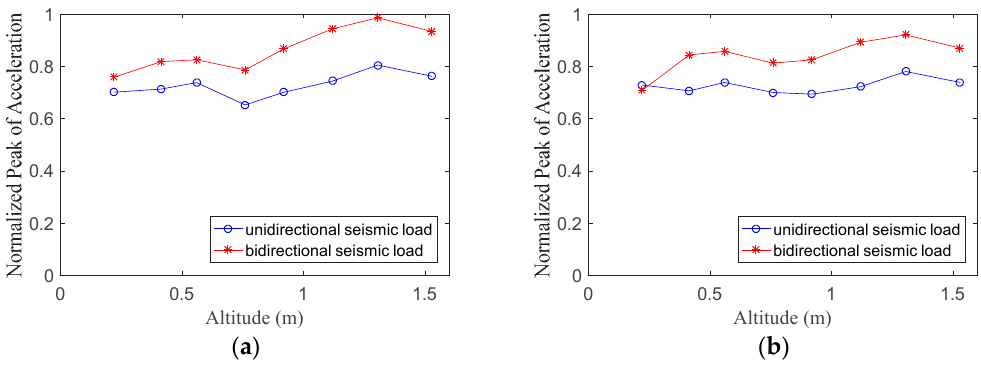
Figure 20. Structural peak acceleration of the electrical platform under a unidirectional and bidirectional seismic wave. ( a ) With water and ( b ) without water. seismic wave. ( a ) With water and ( b ) without